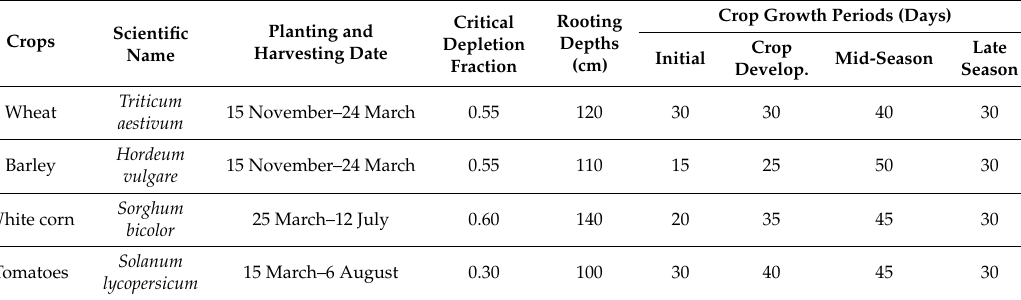
Table 1. Data for the four crops in this